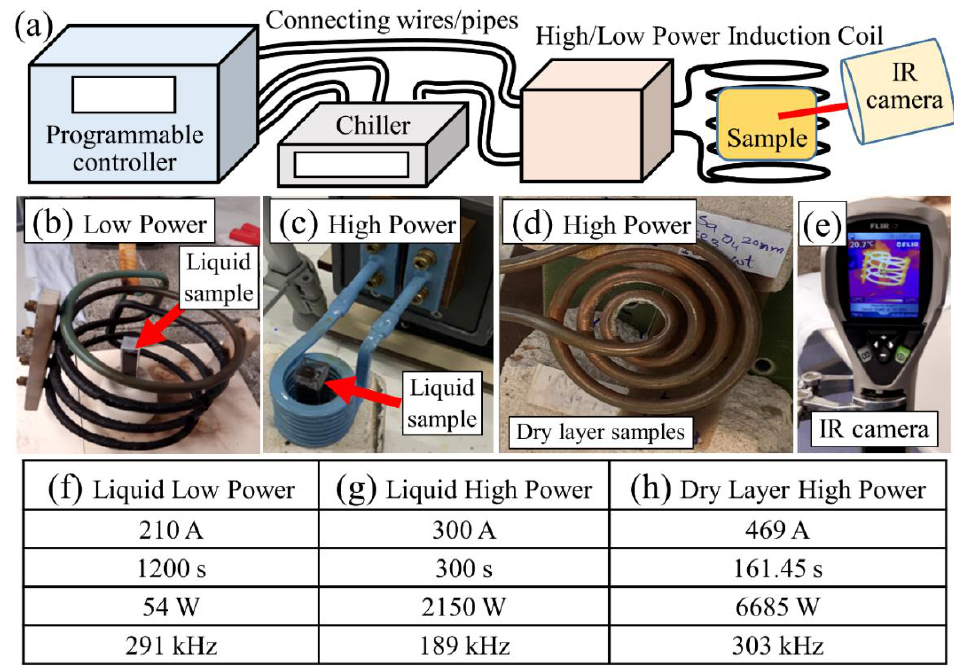
Figure 4. Setups used: ( a ) schematic representation of the experimental setup, ( b ) setup of low-power induction heating system for AMF test of liquid samples (tested at DCU university lab), ( c ) setup of high-power induction heating system for AMF test of liquid samples (tested in Ambrell lab), ( d ) setup of high-power induction heating system for AMF test of dry samples (tested in Ambrell lab), ( e ) IR camera used to monitor changes in the samples’ temperature upon exposure to AMF. The exposure conditions for ( b – d ) are labelled, respectively, as ( f – h ) in table.